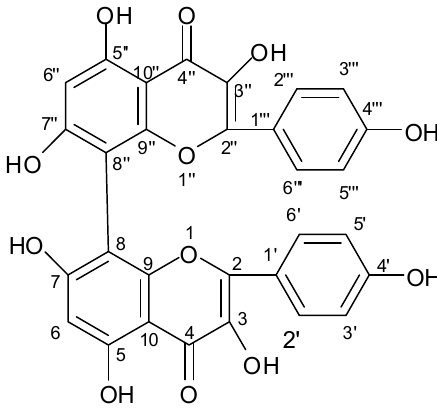
Figure 1. Molecular structure of the biflavonoid extracted from shells of Camellia oleifera